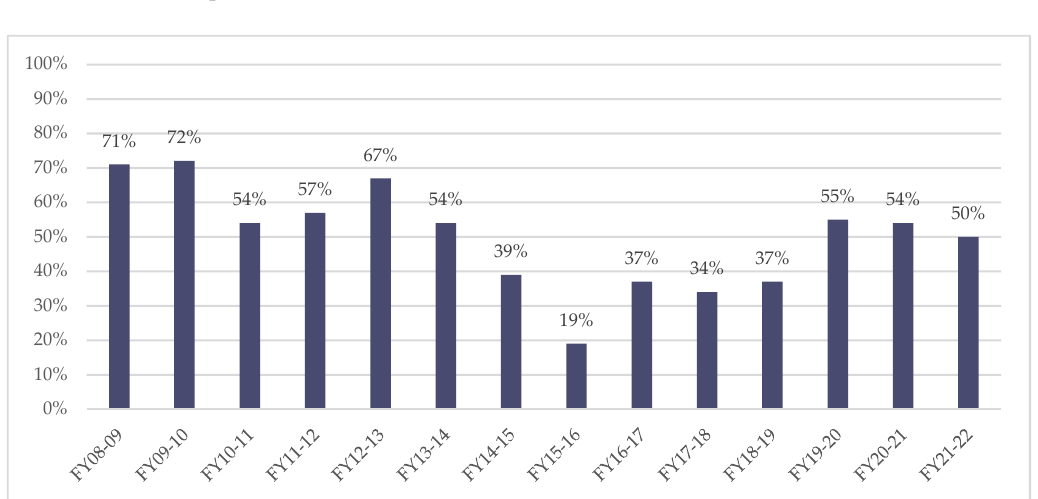
Figure 4. Annual percentage of second SMS-NACs completed of first SMS-NACs. On commencement of the QIP, a target of 50% was set and an Excel spreadsheet was created with built-in coding, which enabled inpatients to be flagged as they approached discharge and reminders provided at the weekly Consultant/MDT review meeting. This led to an 18% increase the following year. In 2018, following nudge theory principles [58], individual email reminders were sent by the MDT/Consultant treating team to show pro- gress. This led to some teams developing healthy competition to maintain their record of no outstanding second SMS-NACs, to the extent that there has been an overall 31%